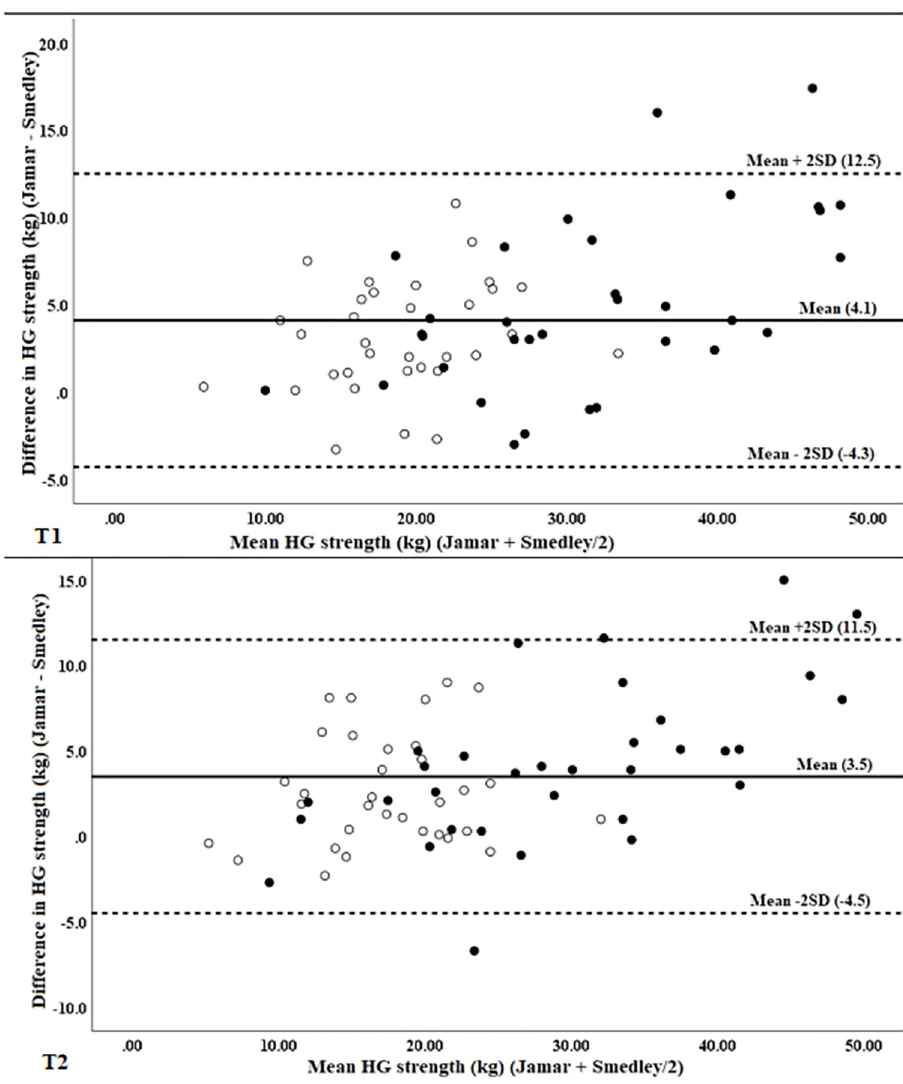
Fig 3. Bland-Altman plots for differences against mean values of hand grip strength measured with the Jamar and Smedley dynamometers at T1 (top) and T2 (bottom) stratified by gender. (women = empty circles, men = solid